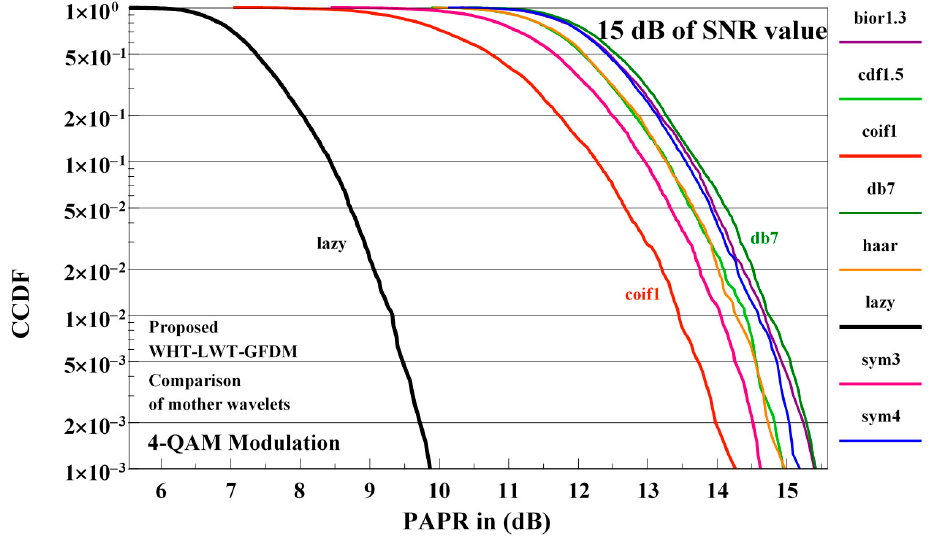
Figure 11. The influences of the different mother wavelets on PAPR performance of proposed waveform in 15 dB of SNR value for 4-QAM signal.